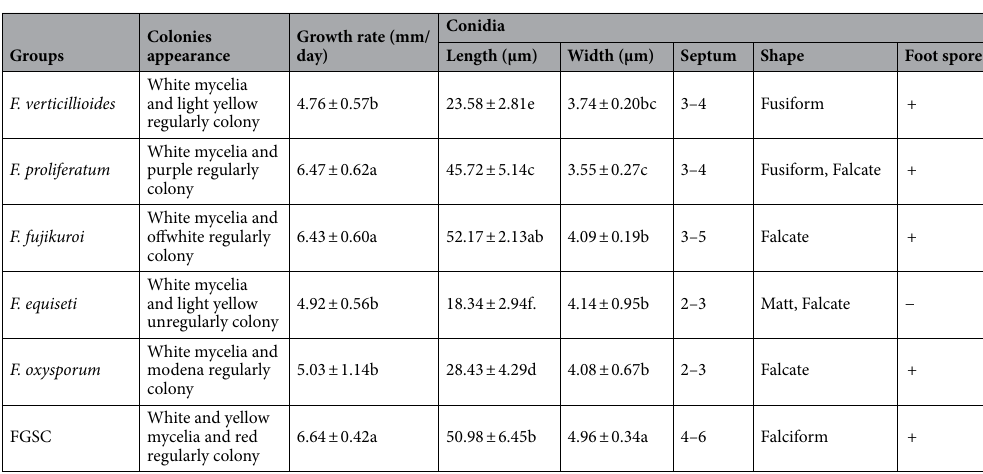
Table 2. The morphological characteristics of Fusarium species were observed on PDA for 3 days at approximately 25 °C under 12 h of light per day. Different lowercase letters indicate a significant difference at the 5% level by Duncan’s least significant range test. FGSC: Fusarium graminearum species